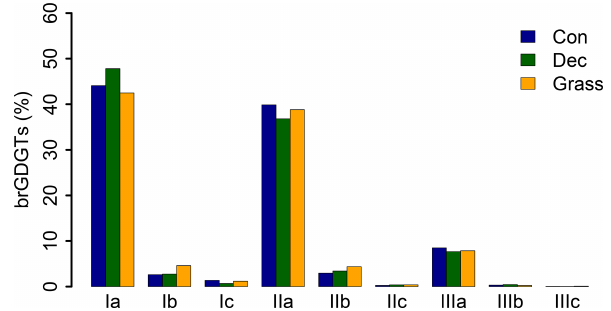
Figure 2. Mean concentrations of individual brGDGTs as percent- age of all brGDGTs for the three investigated types. Abbrevia- tions: con: coniferous forest sites ( n = 9); dec: deciduous forest sites ( n = 14); grass: grassland sites ( n =